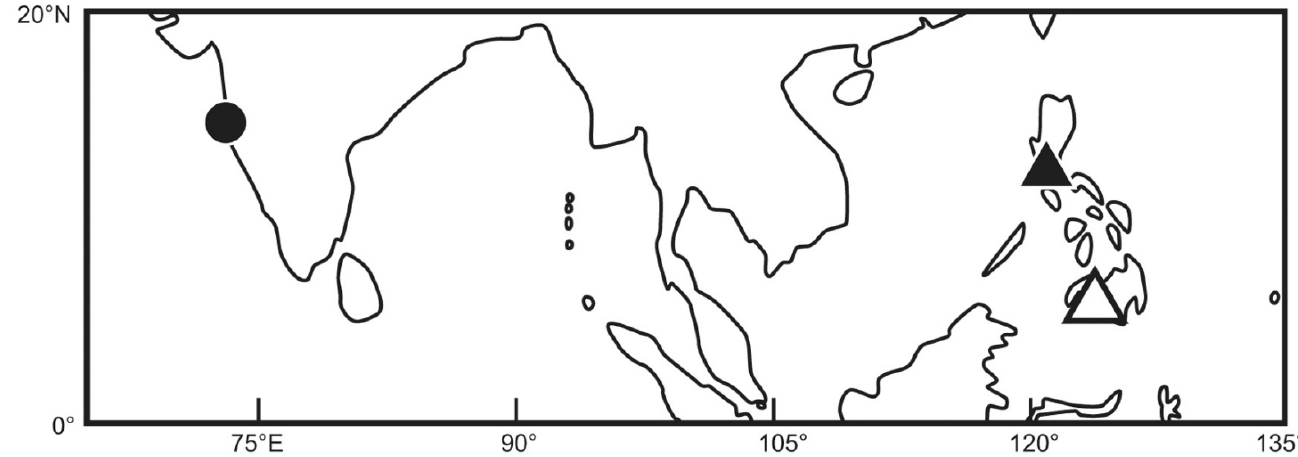
Figure 2. Distributional records of Stolephorus ronquilloi (triangles) And S. hindustanensis n. sp. (circle). Solid symbols based on specimens examined in this study; open symbol based on the original description (Wongratana 1983).